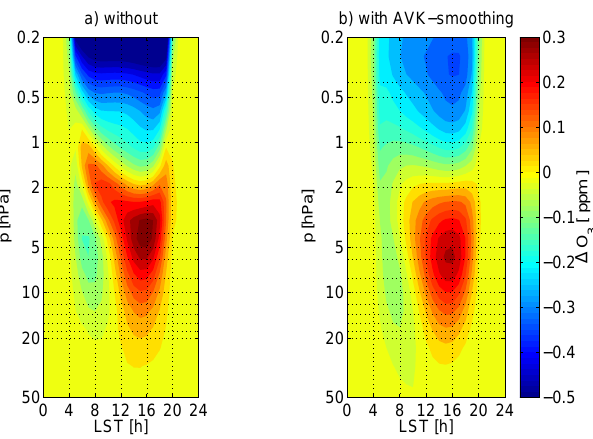
Figure 3. Effect of AVK smoothing on the diurnal ozone variation of WACCM in July 2000. (a) shows the high-resolution model out- put. (b) is the result when the model output is convolved with the averaging kernels of the GROMOS instrument. The AVKs of GRO- MOS are shown in Fig. 2.